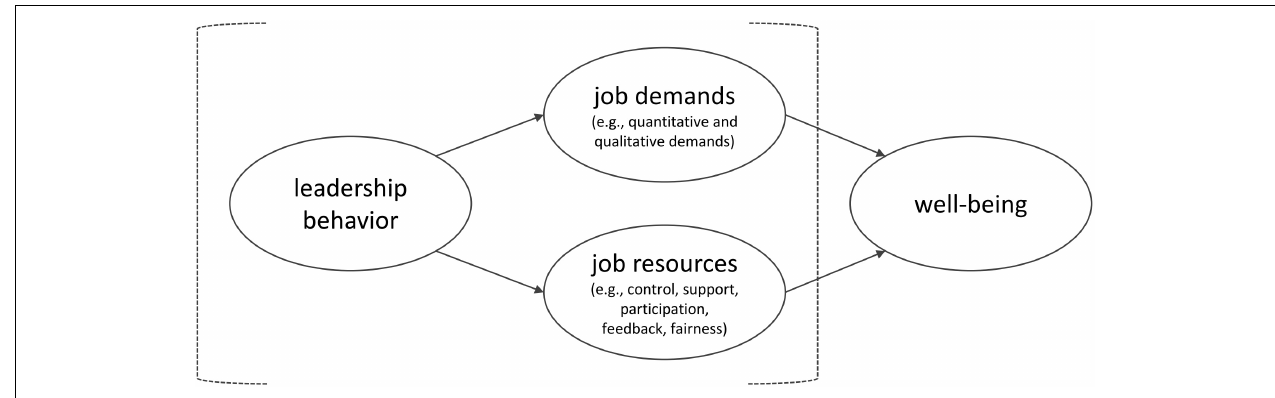
FIGURE 1 | Integrative framework of health- and development-promoting leadership behavior: leaders affect employee well-being through designing employees’ work characteristics.